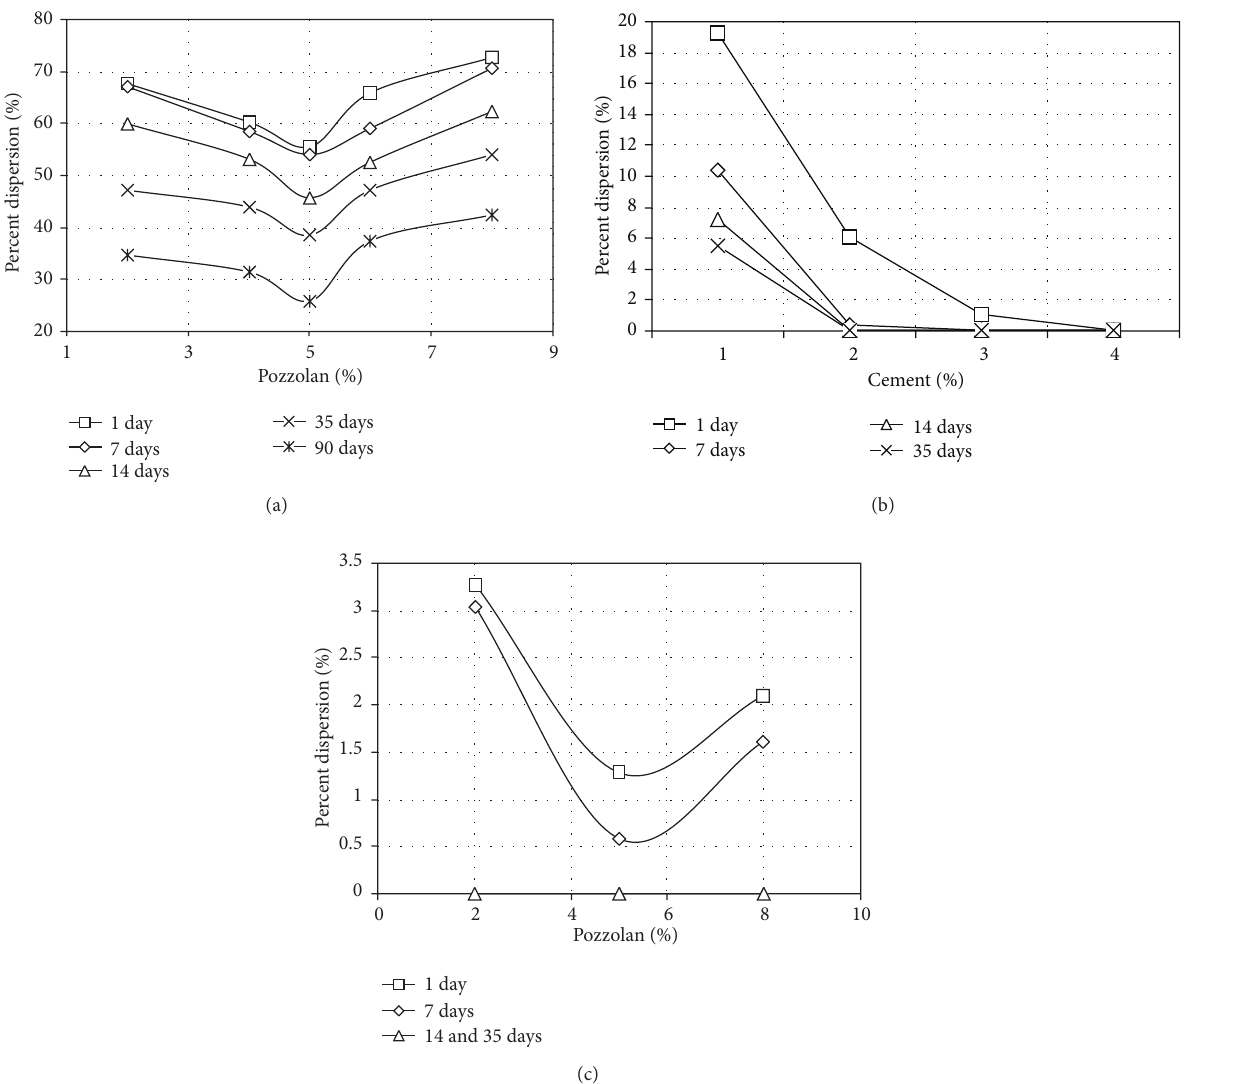
Figure 2: Percent Dispersion of samples treated; (a) with pozzolan contents and different curing times, (b) with cement contents and different curing times, and (c) with different pozzolan contents plus 1.5% cement content and different curing times.